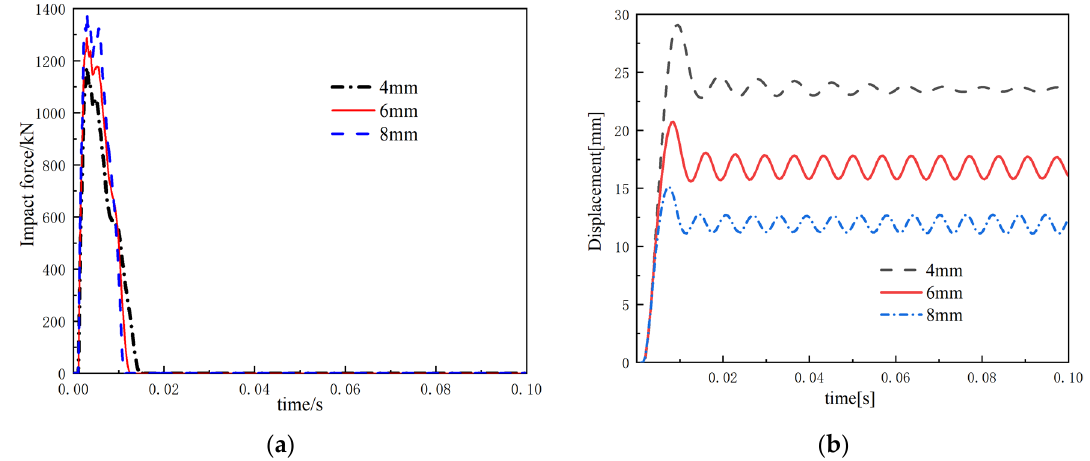
Figure 15. Different thicknesses of tube. ( a ) Impact-time history curve. ( b ) Displacement-time history curve.